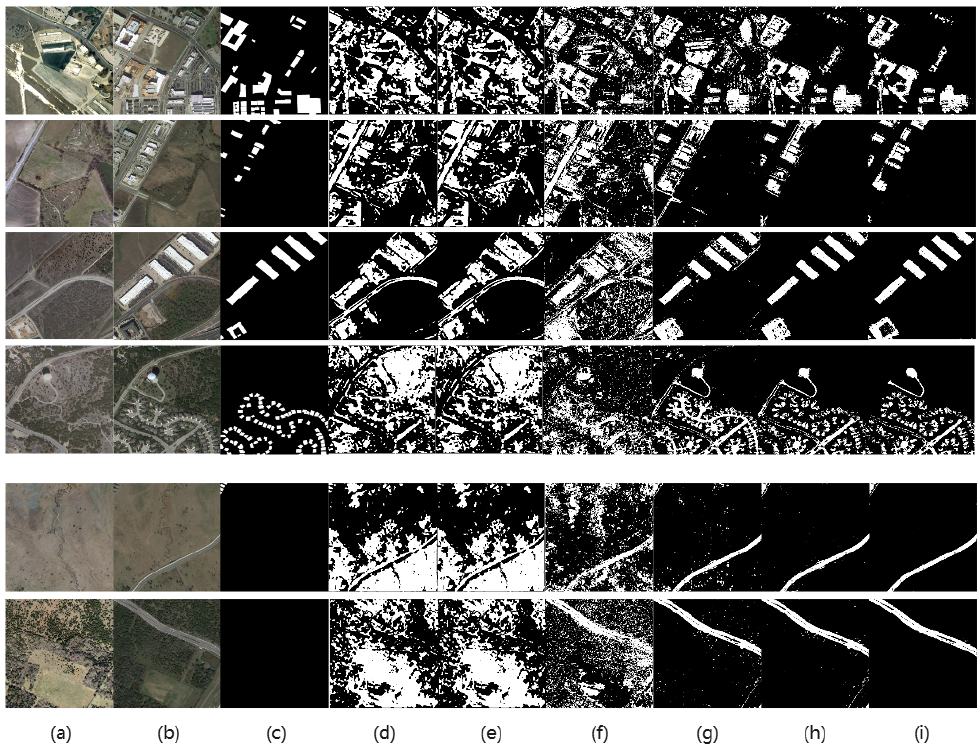
Figure 8. The change maps on LEVIR-CD.( a ) image 1; ( b ) image 2; ( c ) ground truth; ( d ) CVA; ( e ) PCAKmeans; ( f ) MAD; ( g ) SFA; ( h ) DSFA; ( i ) ASFA. Compared with other unsupervised methods, our algorithm has the advantage in change detection for very high-resolution